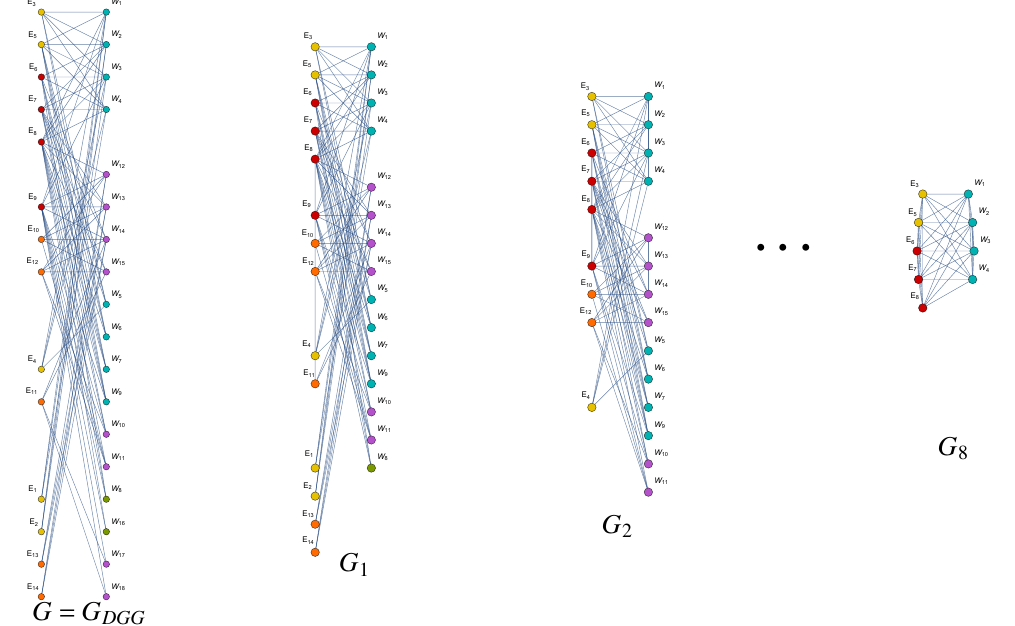
Fig. 8 The sequence of isospectral reductions G = G DGG , G 1 , G 2 ,..., G 8 of the DGG network using the reduction criterion Γ deg that selects all vertices except those with minimal degree. Edge weights and self-loops are omitted in each reduction as the criterion Γ deg ignores this